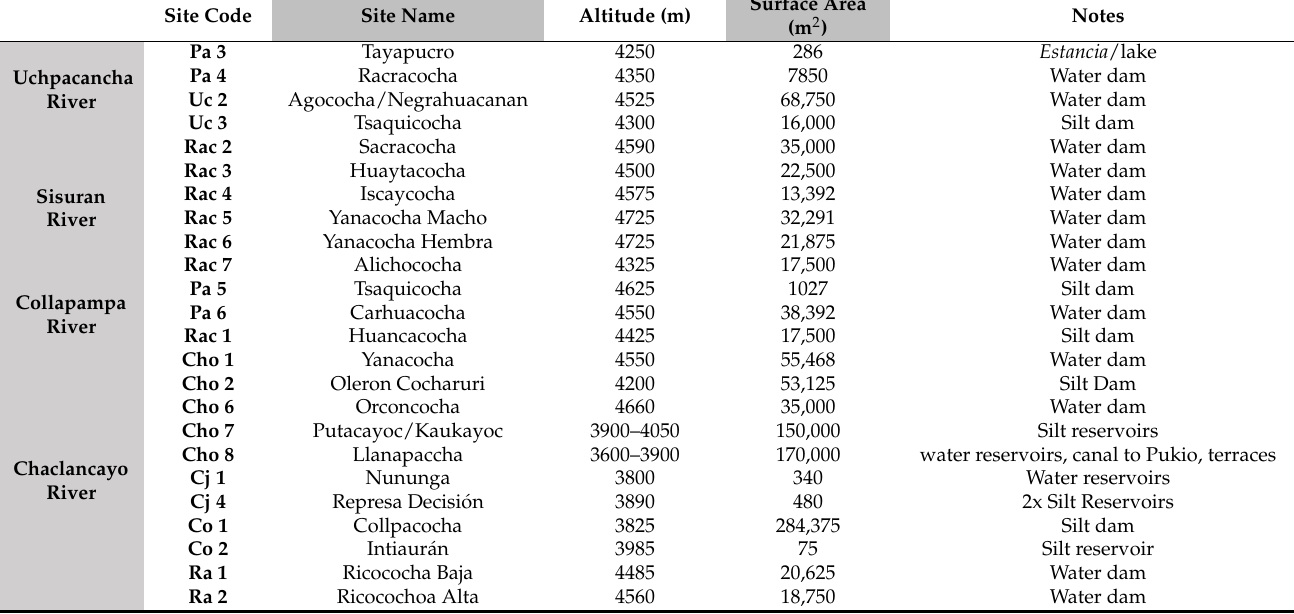
Table 2. The dam and reservoir infrastructure in the study area by the principal